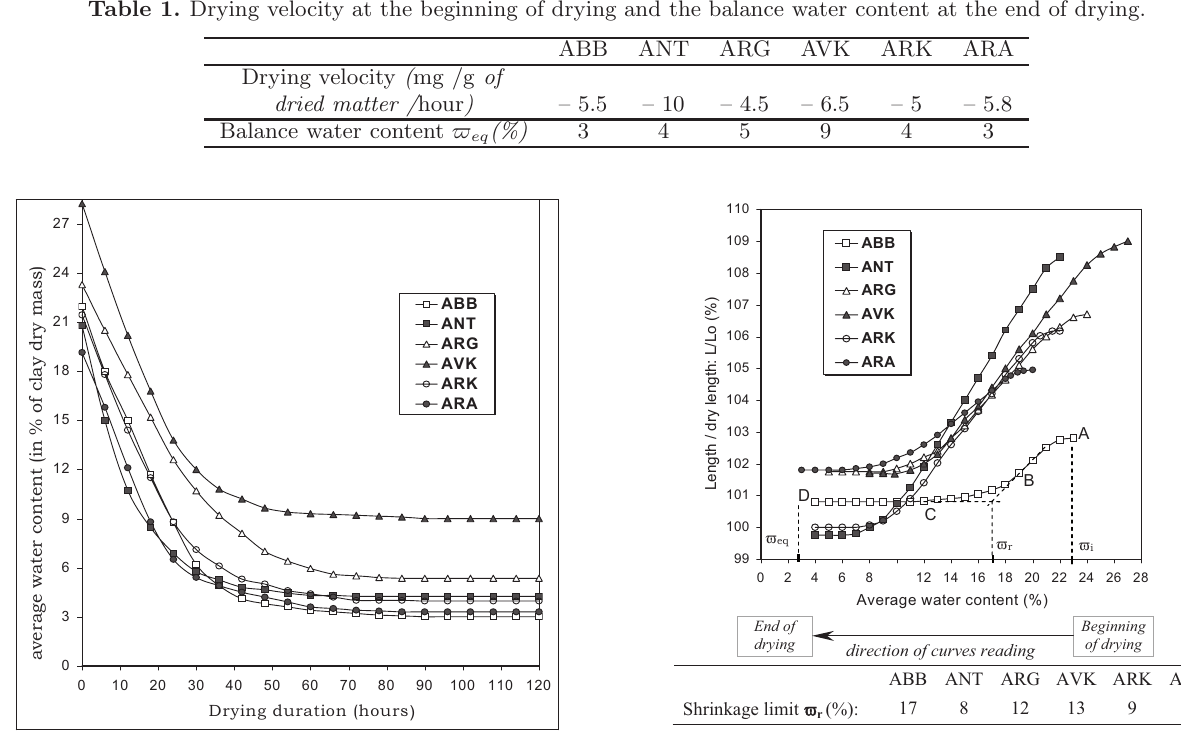
Fig. 4. Variation of the average water content of clay matrixes during drying.